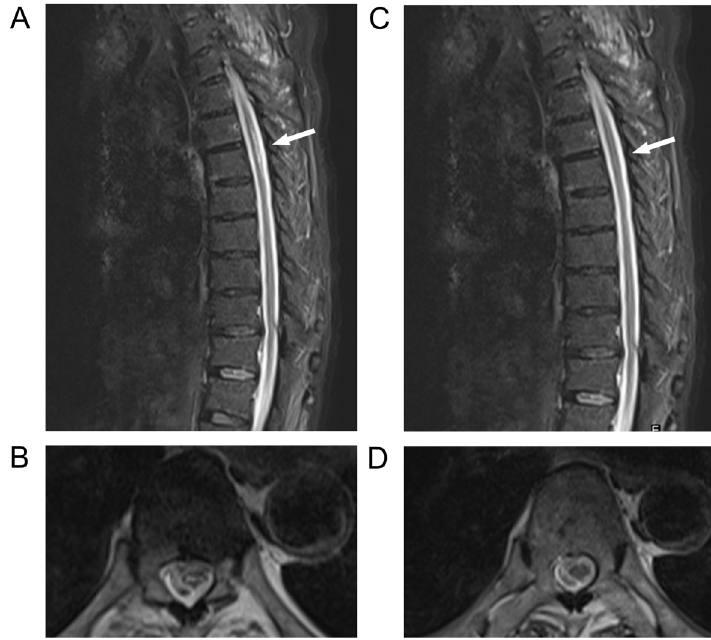
Figure 1. T 2 -weighted magnetic resonance images of thoracic vertebra in Case 1 at the time of the fi rst ( A and B ) and last admissions ( C and D ). A , Sagittal view shows the thoracic spinal cord with a high-signal focus (arrow). B , Axial view shows the thoracic spinal cord and the ‘‘ small print ’’ sign (at the T5-T6 level; arrow). C , Sagittal and D , axial views show that the thoracic spinal cord lesions had partially recovered (at the T5-T6 level;